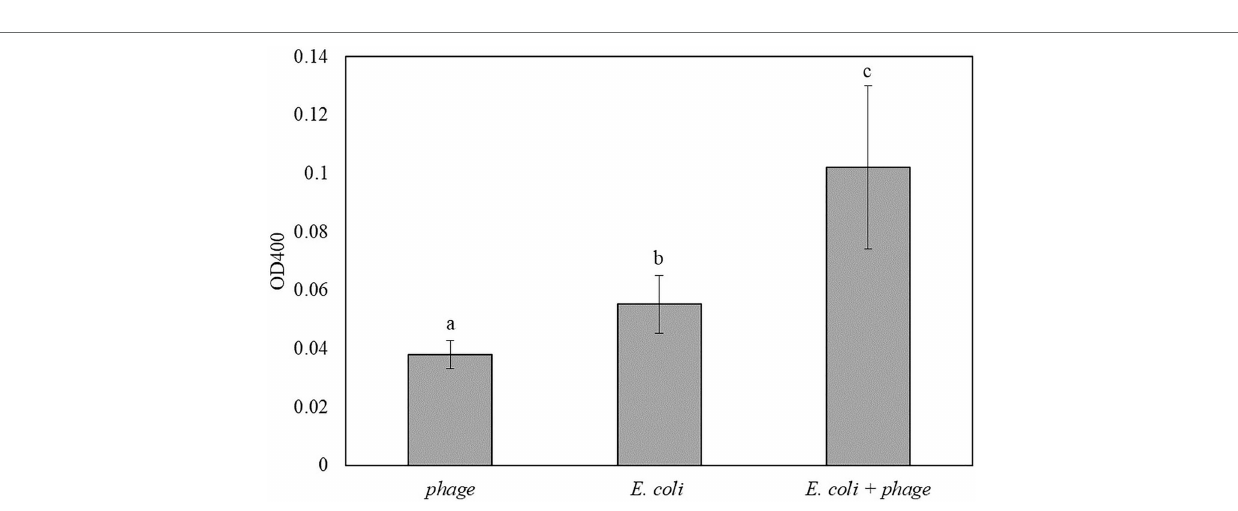
FIGURE 5 | The OD400 of 5 h-enriched 10 CFU/ml E. coli BL21 and 30 min infection with bacteriophage T7-ALP in TSB after enzymatic reaction with p NPP for 2 h. Treatments with different letters are significantly different ( p < 0.05) error bars indicate ±standard deviation of